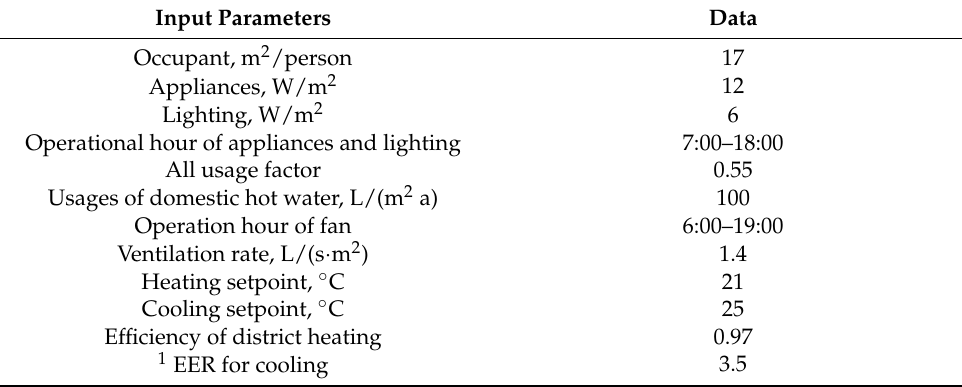
Figure 2. Views of a single floor and whole building model. Table 1. Input data according to EN 16798-1:2018 [34,35].